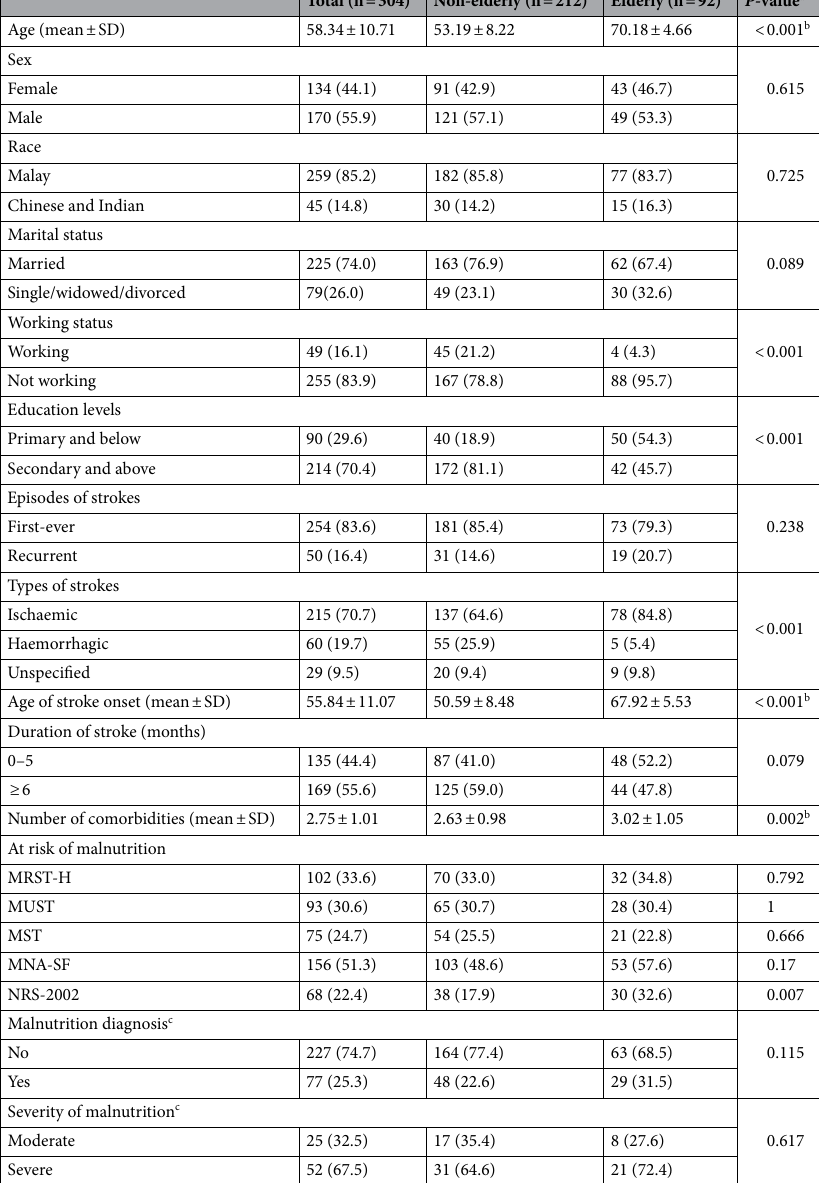
Table 5. Comparison of sociodemographic, clinical, and malnutrition status between elderly and non-elderly groups. MRST-H Malnutrition Risk Screening Tool-Hospital, MNA-SF Mini Nutritional Assessment-Short Form, MST Malnutrition Screening Tool, MUST Malnutrition Universal Screening, NRS-2002 Nutritional Risk Screening, SD Standard deviation. a Chi-square test for independence b Independent t-test; Significance level at P < 0.05. c Malnutrition diagnosis and severity was defined by the diagnostic criteria for malnutrition proposed by the Global Leadership Initiative on Malnutrition (GLIM-DCM) 9